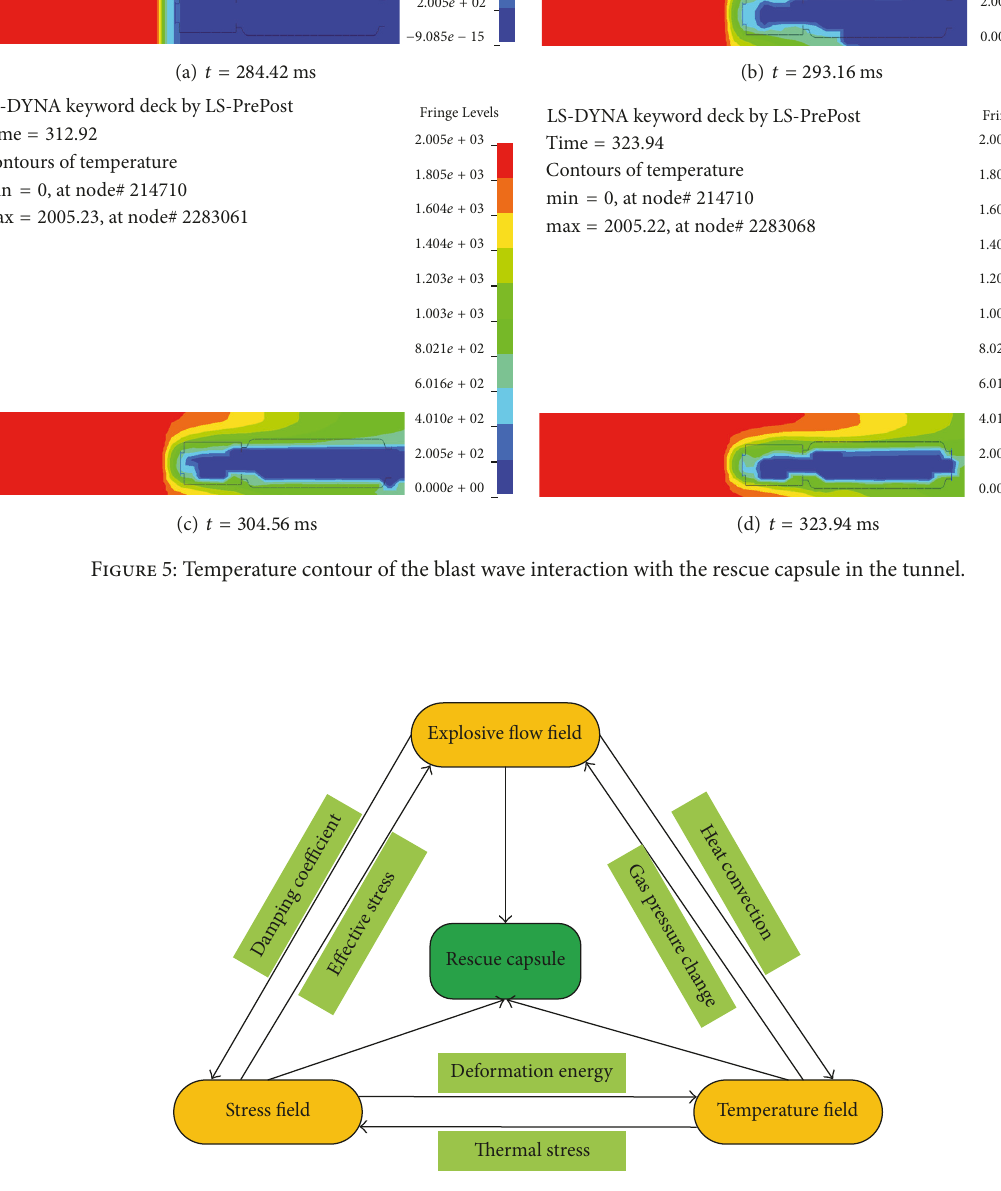
Figure 6: Coupling relationship between the explosion flow field, stress field, and temperature